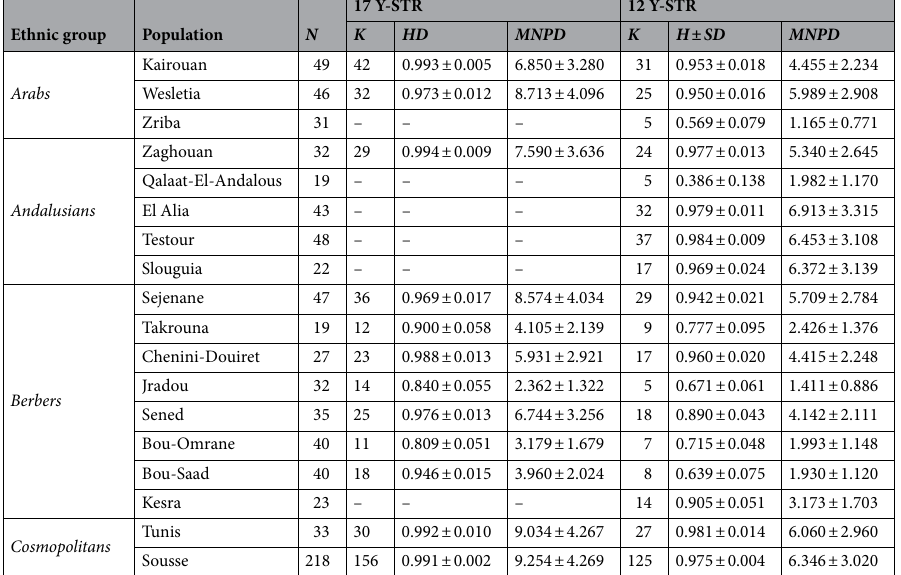
Table 1. Y-chromosome genetic diversity parameters in Tunisian populations. N: Sample size, K: Number of different haplotypes, HD: Haplotype diversity, MNPD: Mean Number of Pairwise